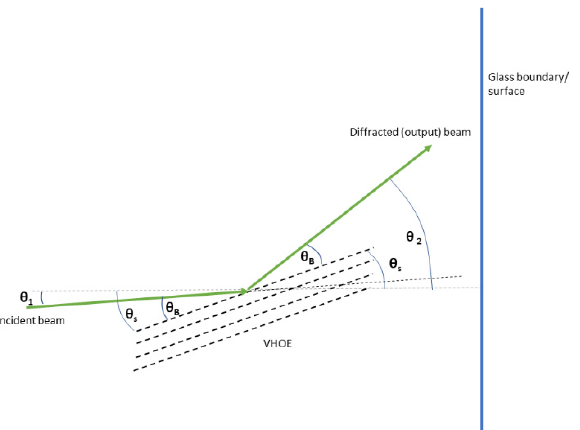
Figure 1. General relation of slant angle with incident angle, Bragg angle and diffraction angle (all angles are within the medium).